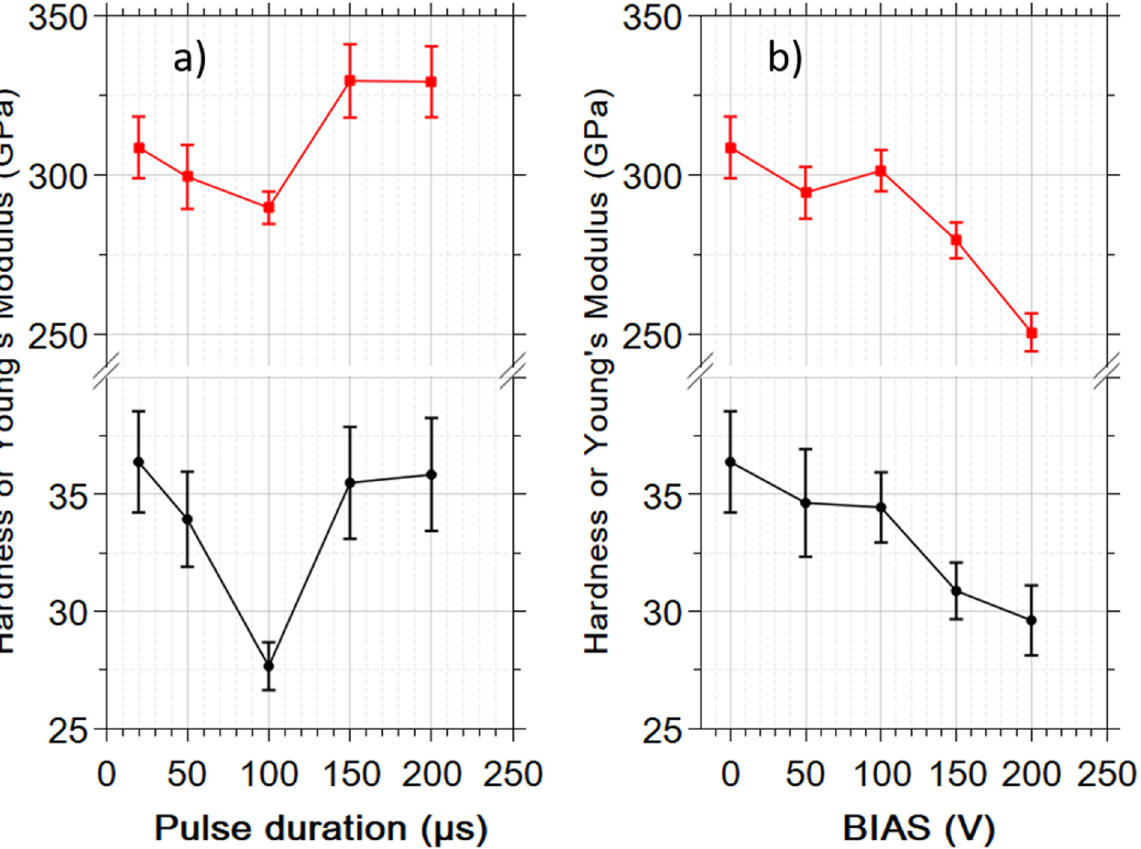
Figure 4. Mechanical properties of coatings deposited with different (a) pulse durations and (b) bias voltages.